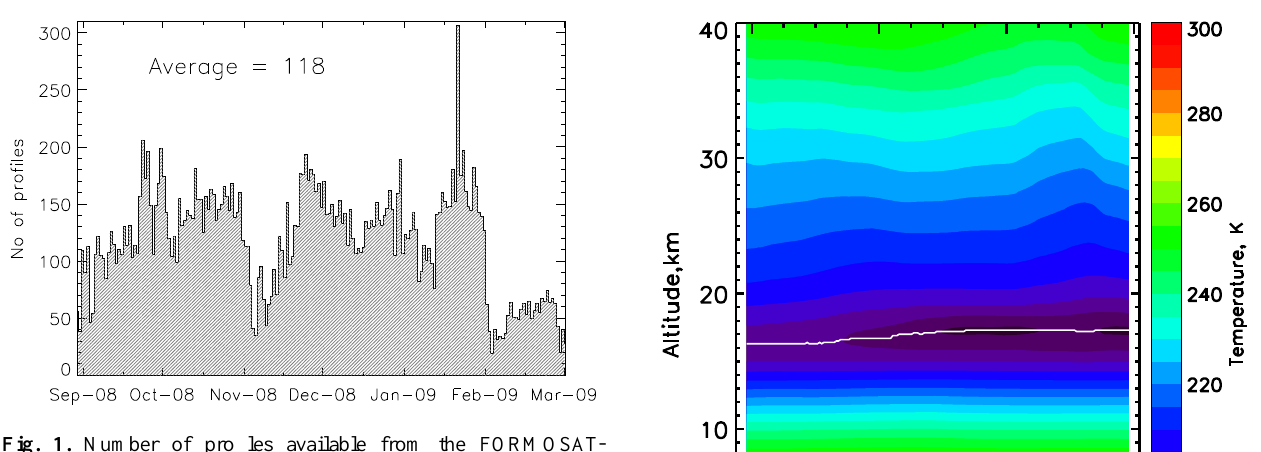
Fig. 1. Number of profiles available from the FORMOSAT- 3/COSMIC observations in 10 ◦ S–10 ◦ N latitude region on each day during September 2008 to February 2009. The average number of profiles per day is 118.